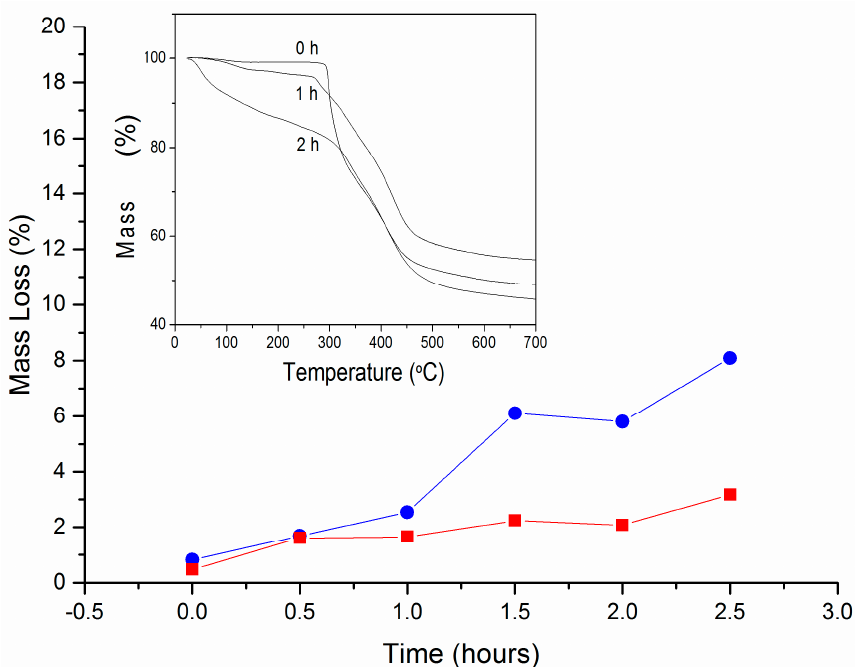
Figure 5. (•) Water and ( ■ ) –COOH mass loss ( w / w %) of PAN membranes as a function of hydrolysis time, and thermogravimetric curves of hydrolyzed PAN membranes for the more representative hydrolysis times.